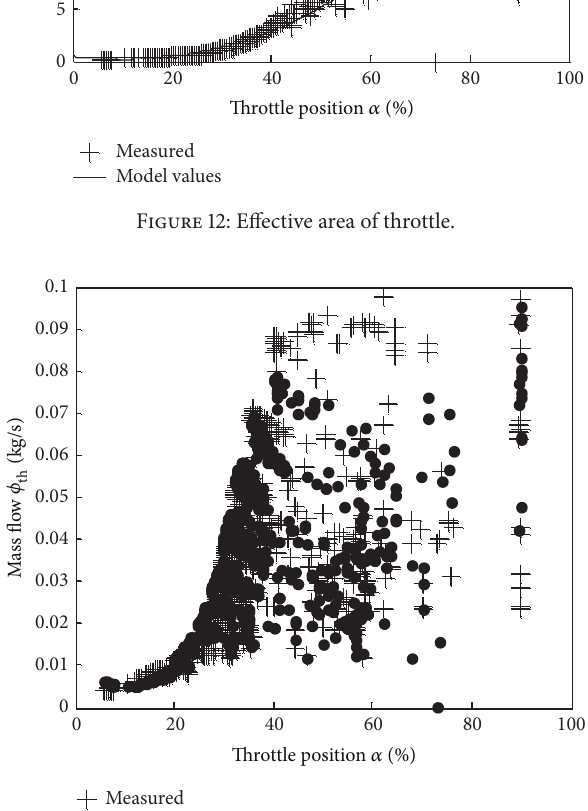
Figure 13: Air mass flow through